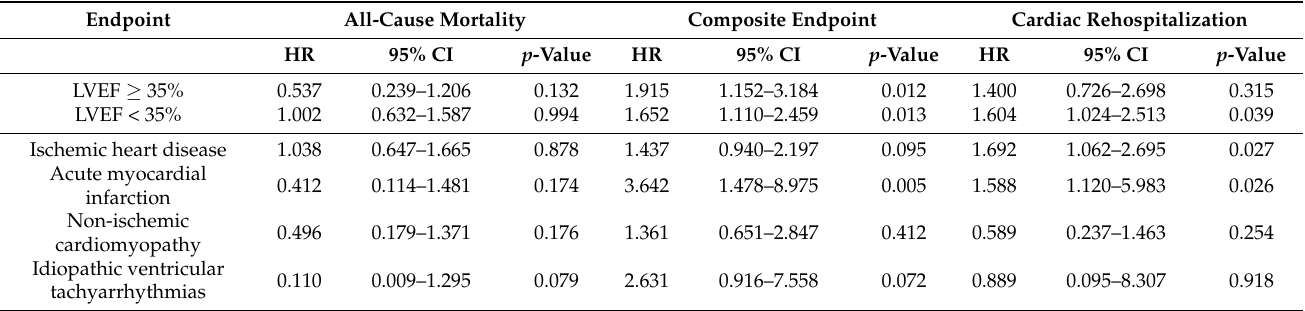
Table 4. Multivariable Cox regression analyses within important subgroups.